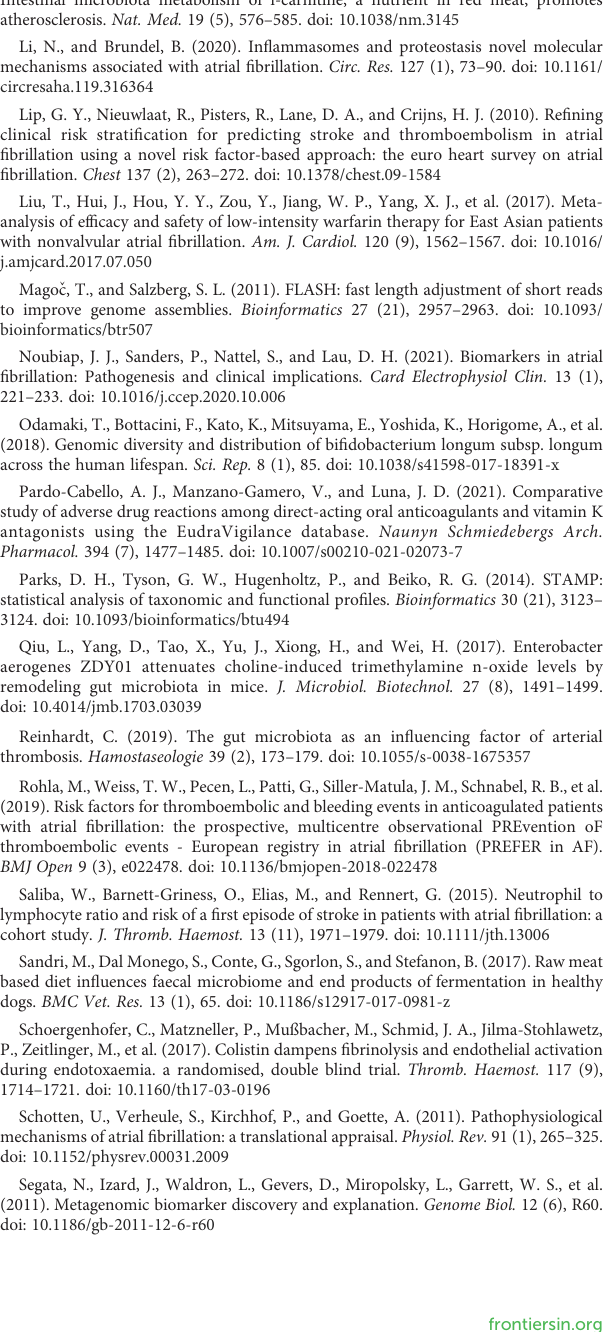
SUPPLEMENTARY FIGURE 1 Gut microbiota diversity analysis in the three groups. (A) Alpha diversity was analyzed by the Shannon index. (B) Alpha diversity was analyzed by the